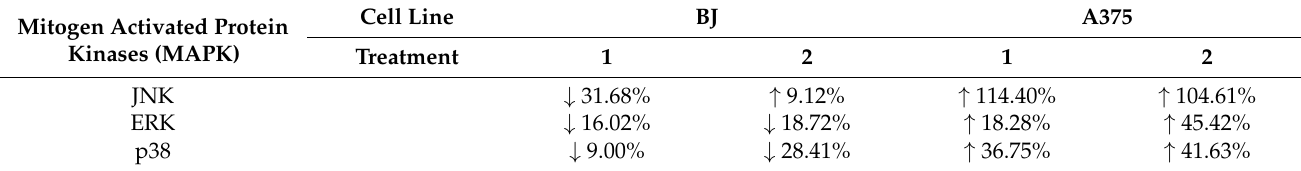
Table 4. The influence of zeaxanthin-rich Goji extracts 1 and 2 on phosphorilated mitogen activated protein (MAP) kinases- driven ROS signaling upregulation (depicted as ↑ ) or downregulation (depicted as ↓ ) in normal and malignant cells in vitro.